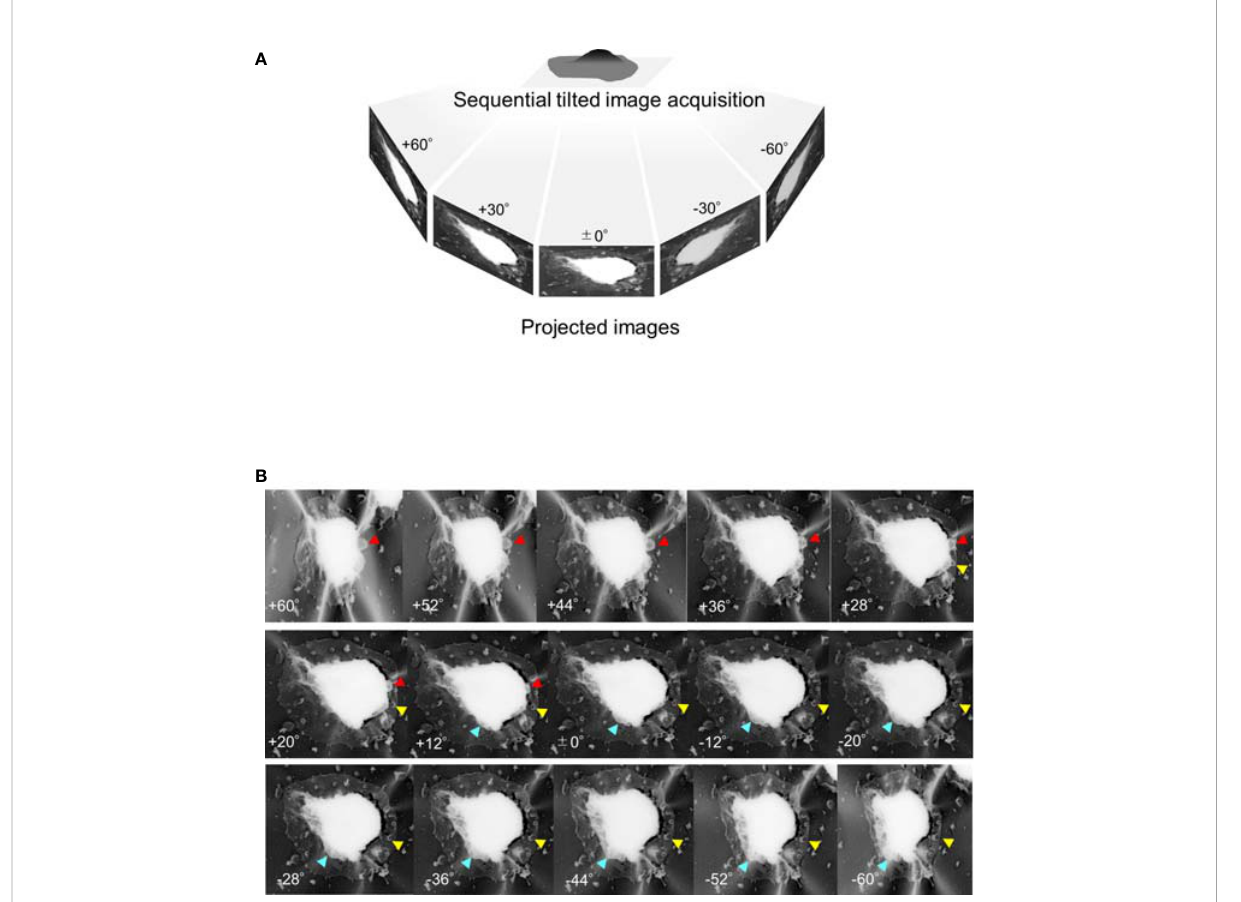
FIGURE 7 Tilting images of unroofed gametocyte-erythrocytes (A) Sequential tilting images of unroofed specimens were acquired with tilting steps at every 2° from − 60° to +60°. (B) Representative images of unroo fi ng-tilt images. By observing the same sample from different angles, the positional relationships between the small bubbles and the host erythrocyte membrane were clearly seen; for example, binding of the small bubble to the erythrocyte membrane (yellow arrowhead) or the gametocyte body (red arrowhead). Also, large exo-membrane; pouches of a kangaroo are showed (blue arrowhead).